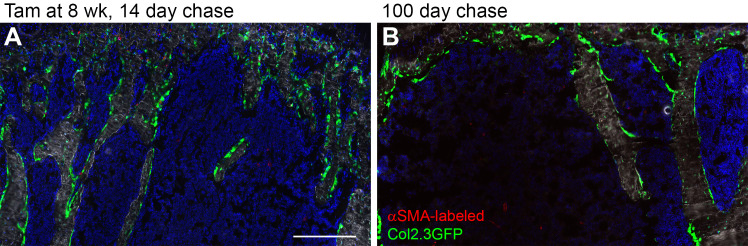
Alpha smooth muscle actin (αSMA) lineage tracing in the bone marrow compartment of adult mice.Proximal tibia trabecular histology in αSMACreER/Ai9/Col2.3GFP mice 14 (A) and 100 days (B) after tamoxifen treatment during adulthood (at least 8 weeks of age). Note that there are few red cells and almost no contribution to osteoblasts or osteocytes. Scale bars are 250 µm. gp, growth plate.